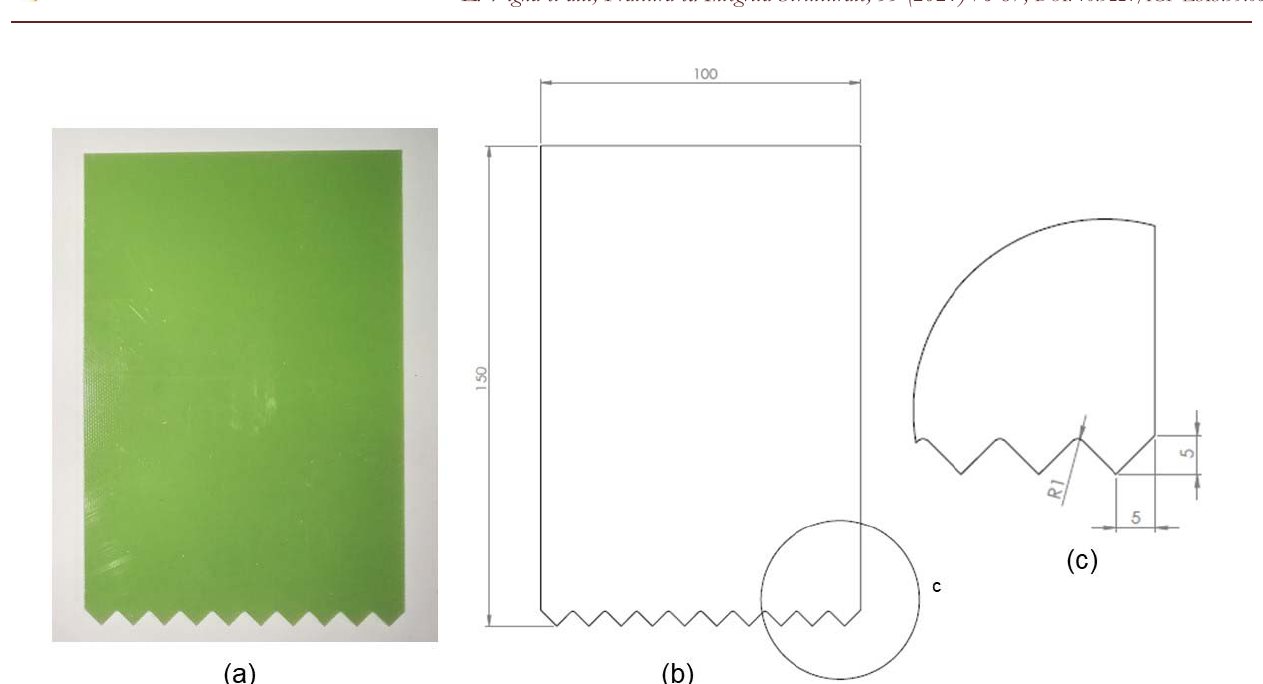
Figure 1: Glass fiber plain specimen for crashworthiness test (dimensions in mm): (a) picture of the specimen, (b) overall dimensions of the specimen, (c) detail of the trigger geometry.